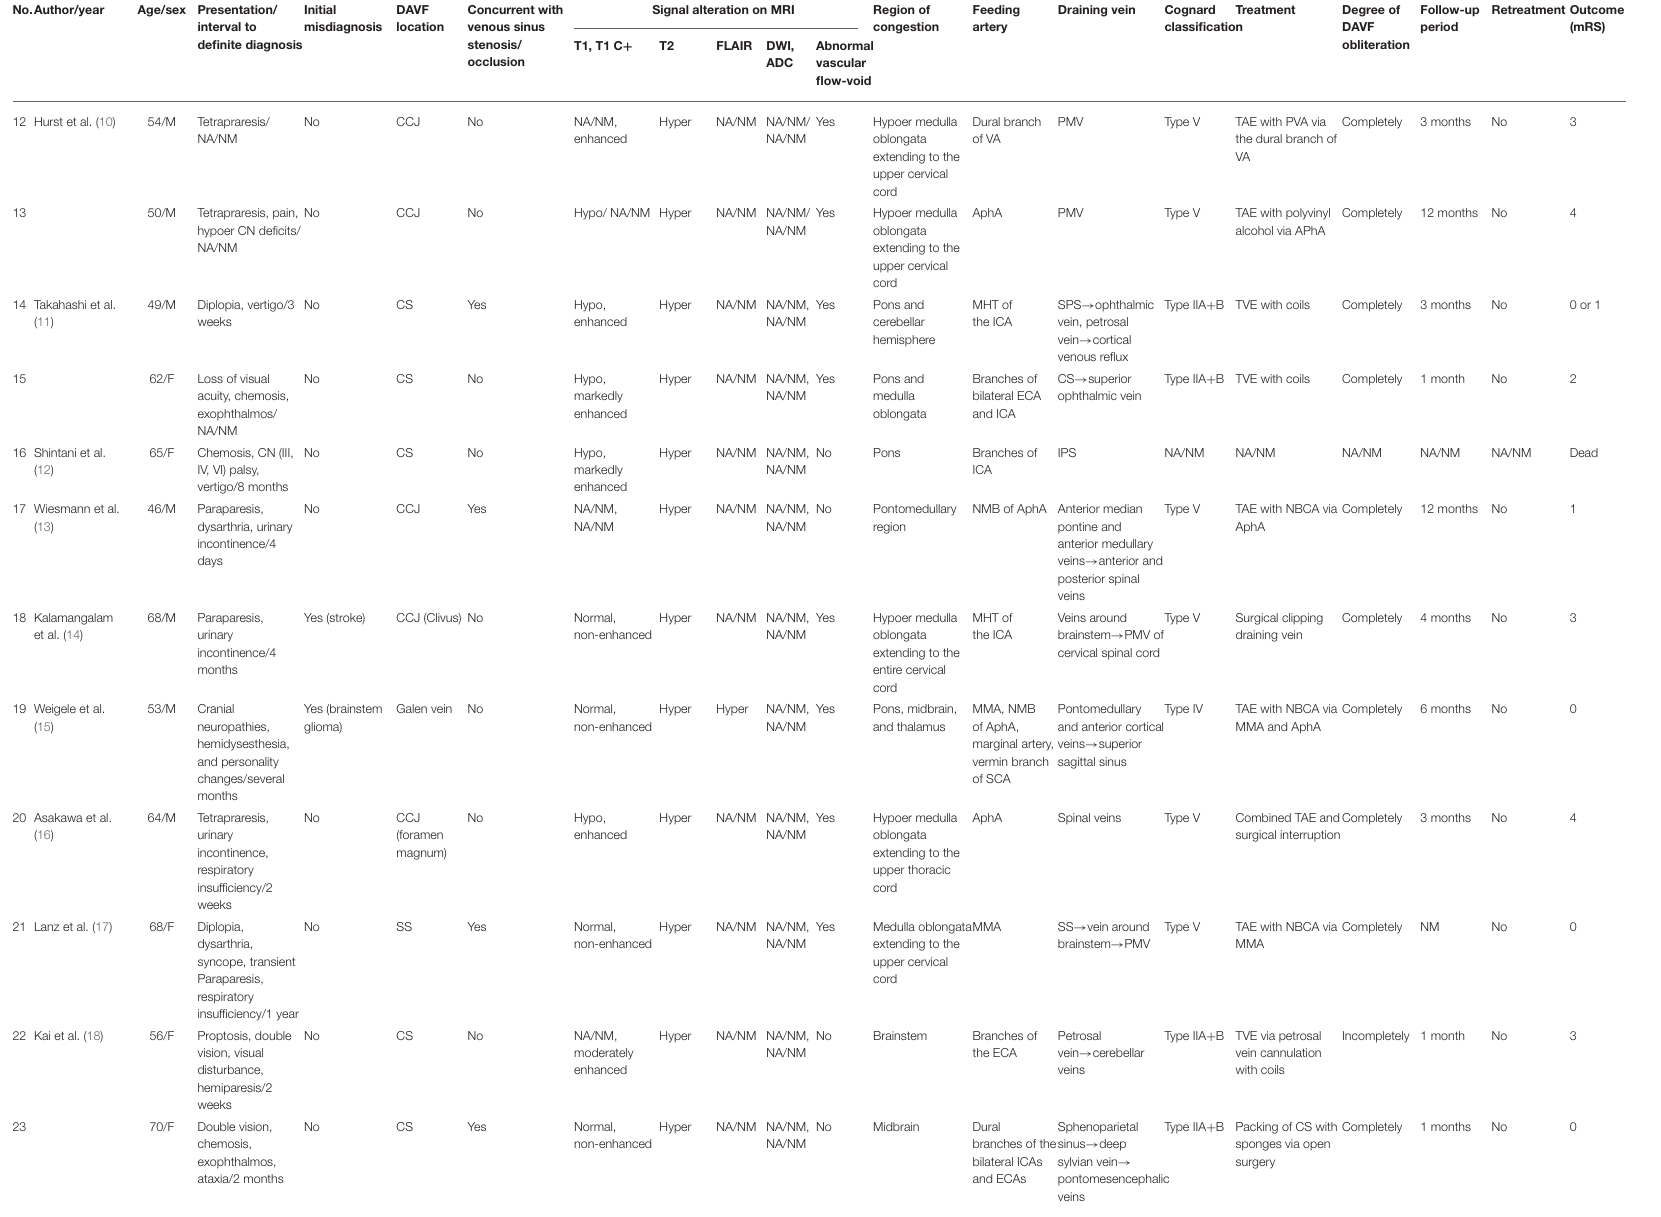
TypeIIA + B PackingofCSwith spongesviaopen surgery